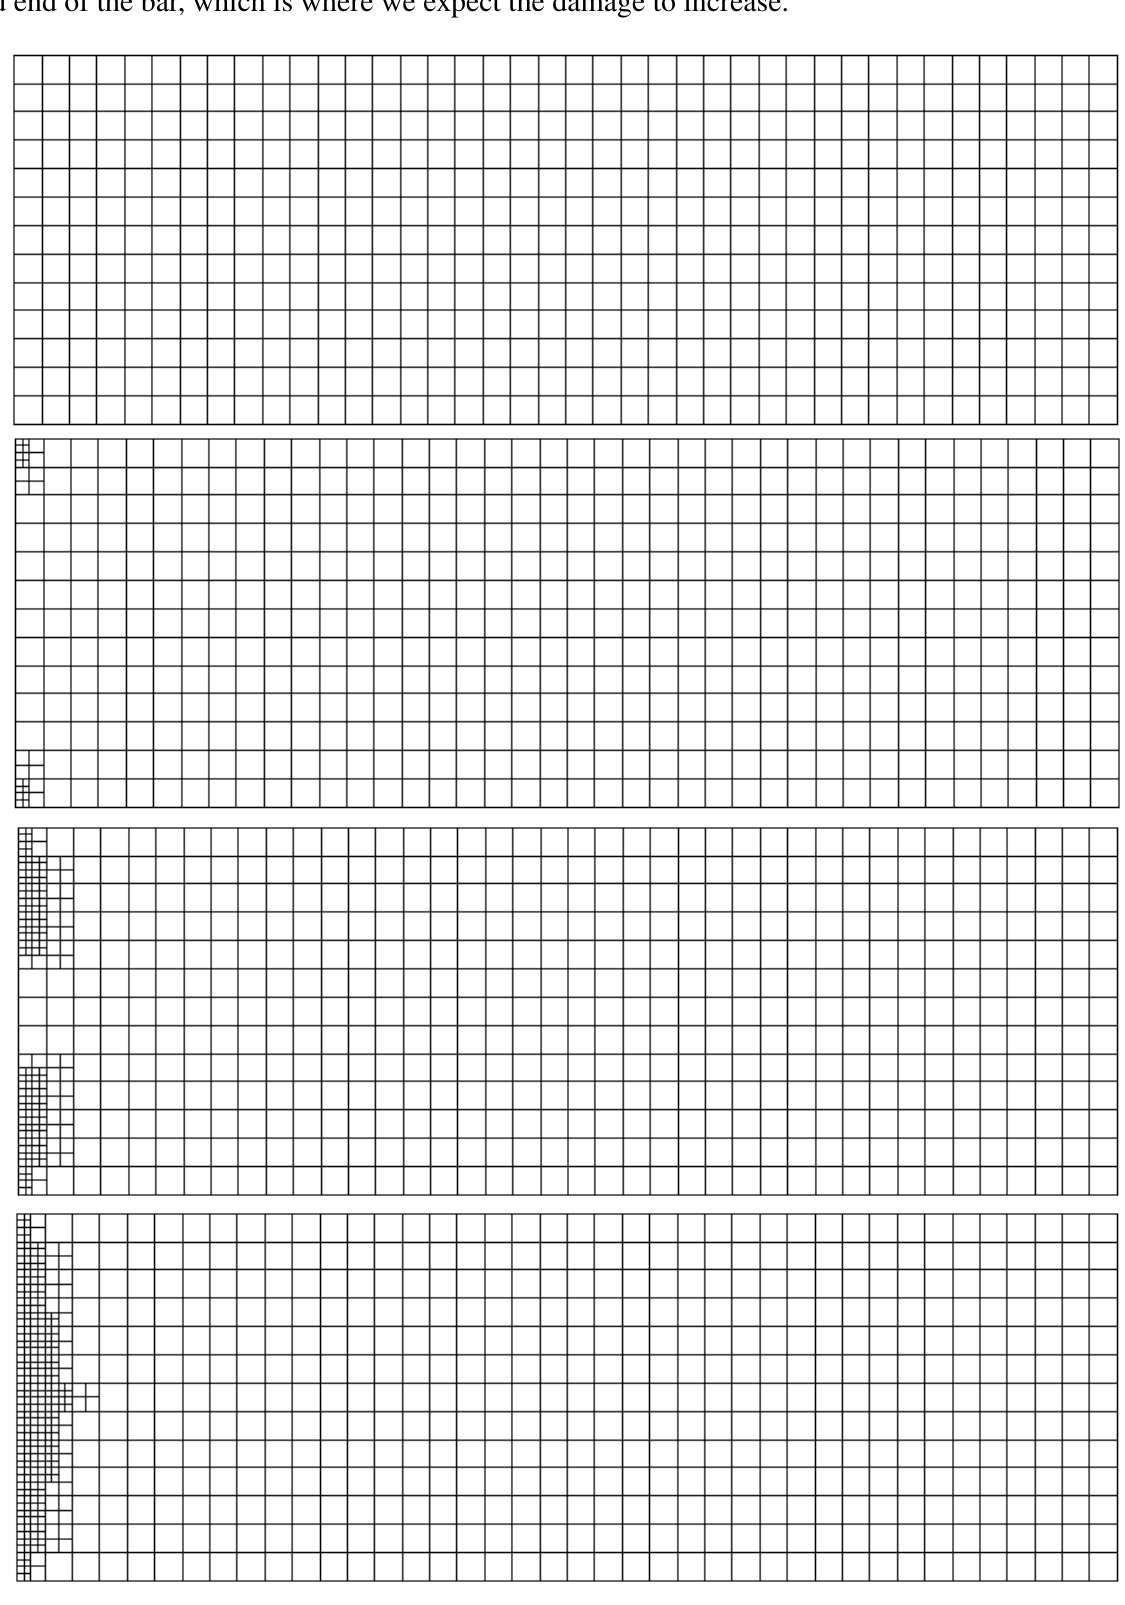
Figure 4 . Damage-based refinement scheme: from top to bottom, triangulations of the two-dimensional bar at times t = 0 , t = 88.5 µ s , t = 106.1 µ s , and t = 115.9 µ s . The refinement is concentrated at the fixed end of the bar, which is where we expect the damage to